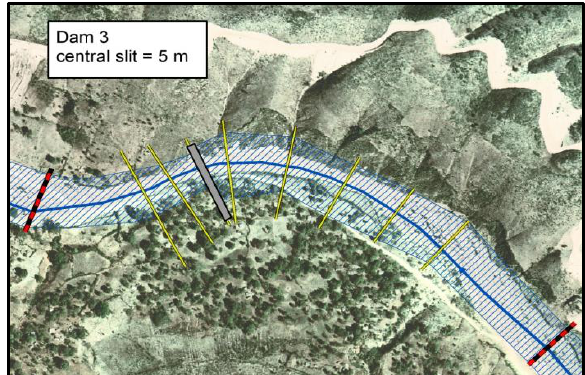
Figure 11. Traces of projected selective check dam in the upper part of the study area (box b on Figure 1) and floodable area for May 2004 event (dashed area)